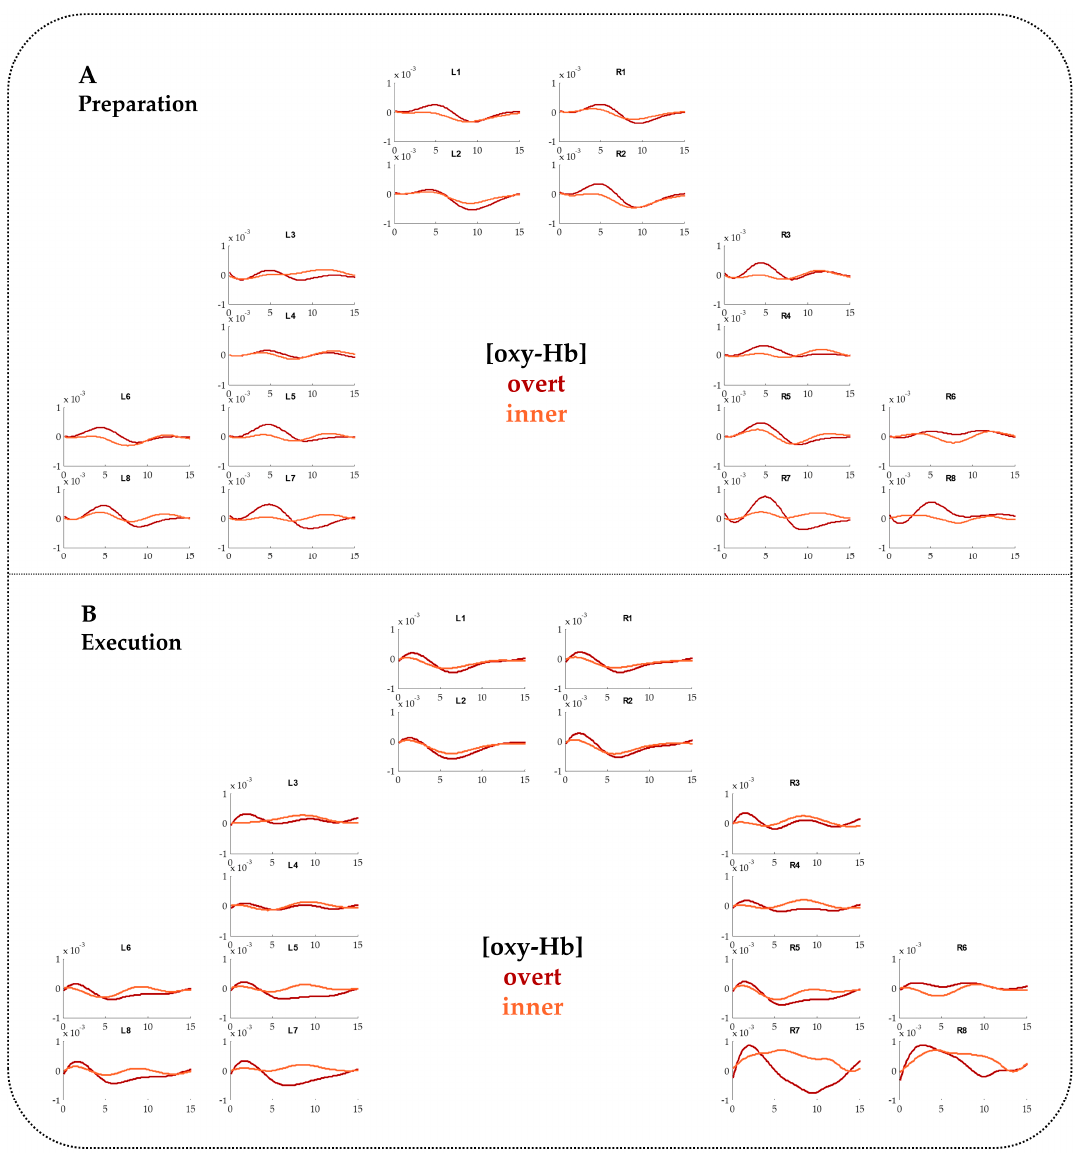
Figure A1. FNIRS time courses for [oxy-Hb] contrasting overt and inner speech for the Preparation phase ( A ) and the Execution phase ( B